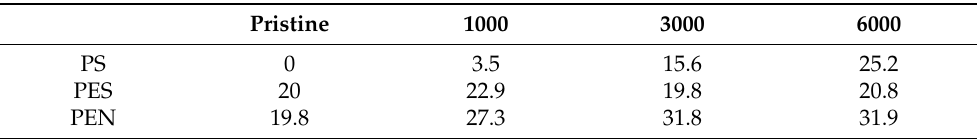
Table 1. Oxygen atomic concentrations for pristine and laser-treated polystyrene, polyethylene naphthalate, and polyethersulfone acquired from XPS spectra. The laser exposure of 10 mJ·cm − 2 with 1000, 3000, and 6000 pulses was applied.